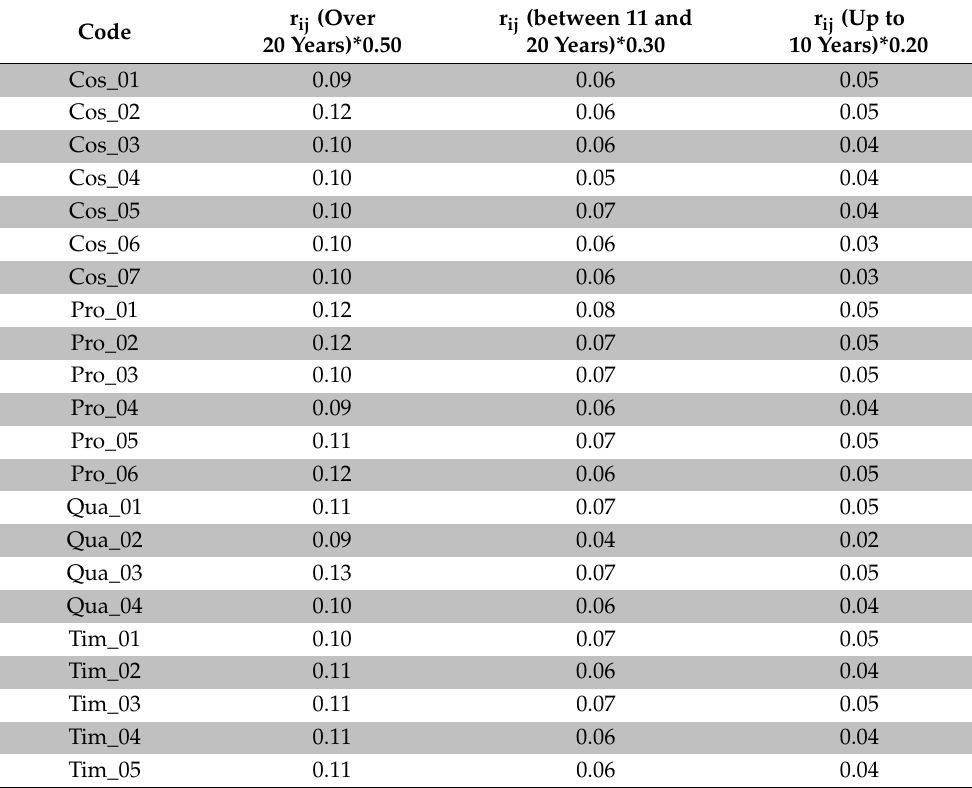
Table 4. Matrix V weighted values. Source: authors.